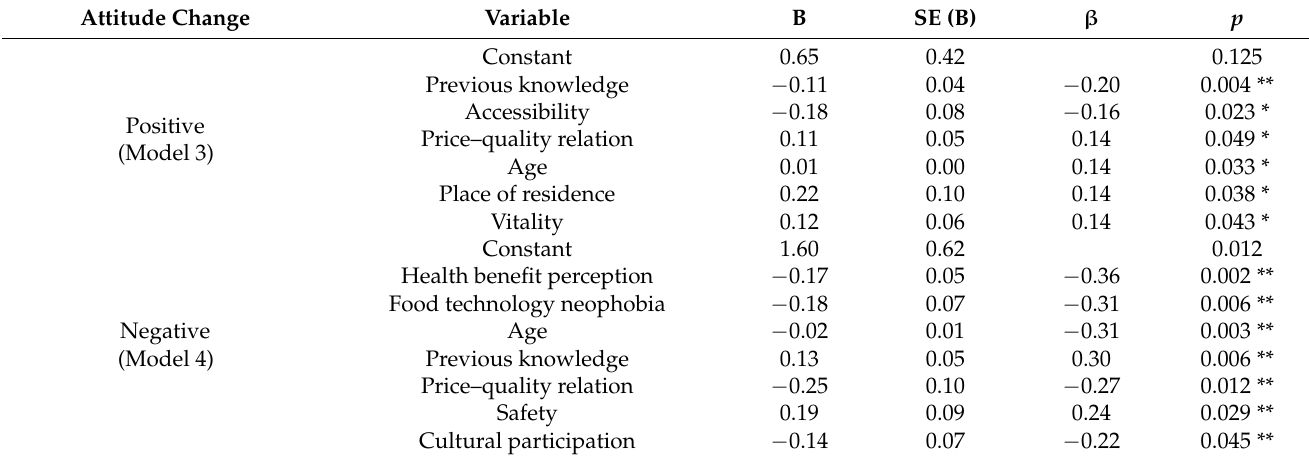
Table 5. Results from multiple linear regression analyses explaining respondents’ attitude changes toward